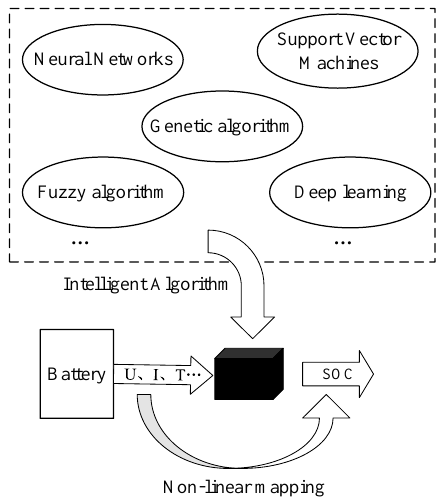
Figure 3. SOC estimation method based on black box battery model.